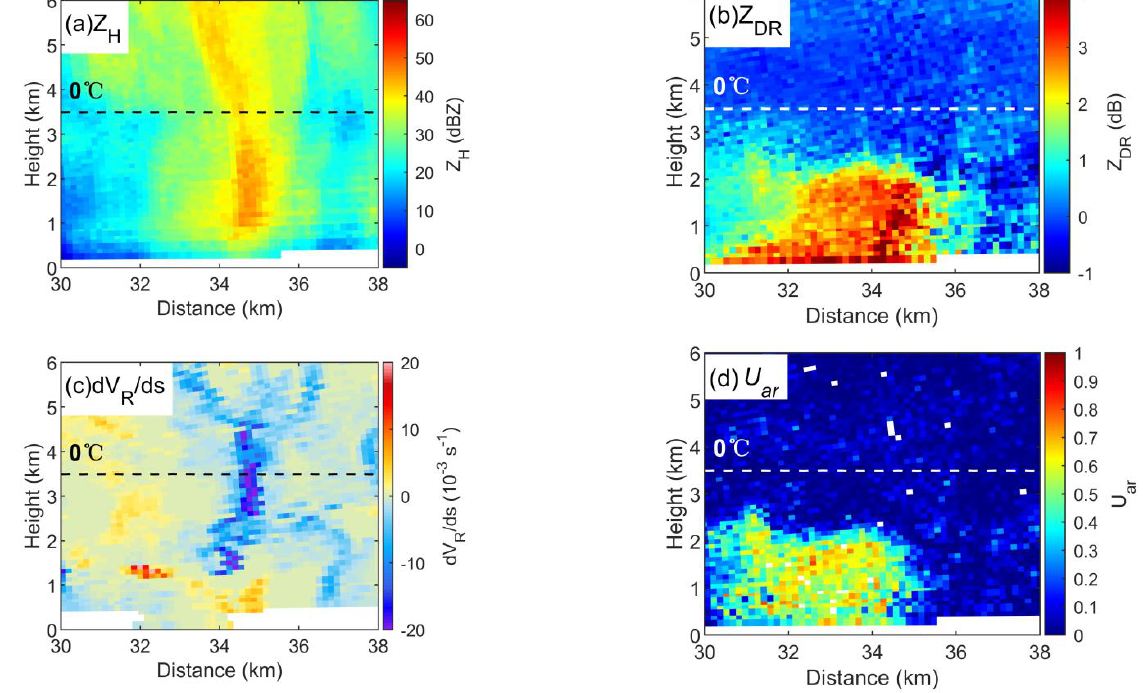
Figure 14. Variables after the Z DR column disappeared. ( a ) Z H , ( b ) Z DR , ( c ) dV R /ds, ( d ) U ar .